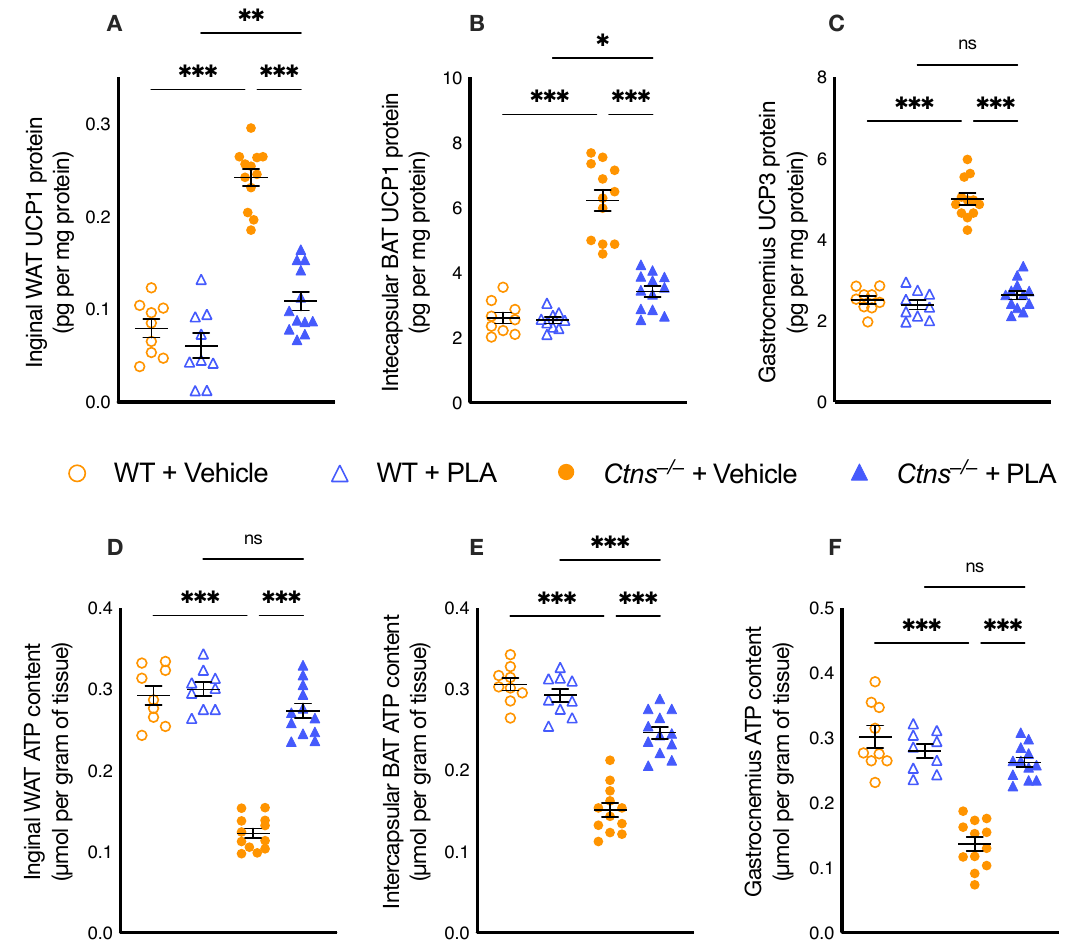
Figure 2. PLA ameliorates energy homeostasis in adipose tissue and skeletal muscle in Ctns − / − mice. UCP and ATP content of inguinal WAT ( A , D ), intercapsular BAT ( B , E ) and gastrocnemius muscle ( C , F ) were measured. Results of vehicle-treated Ctns − / − mice were compared to vehicle-treated WT mice while results of PLA-treated Ctns − / − mice were compared to those of PLA-treated WT mice. In addition, results of PLA-treated Ctns − / − mice were compared to vehicle-treated Ctns − / − mice and specific p -values are shown above the bar. ns signifies not significant, * p < 0.05, ** p < 0.01, *** p < 0.001.